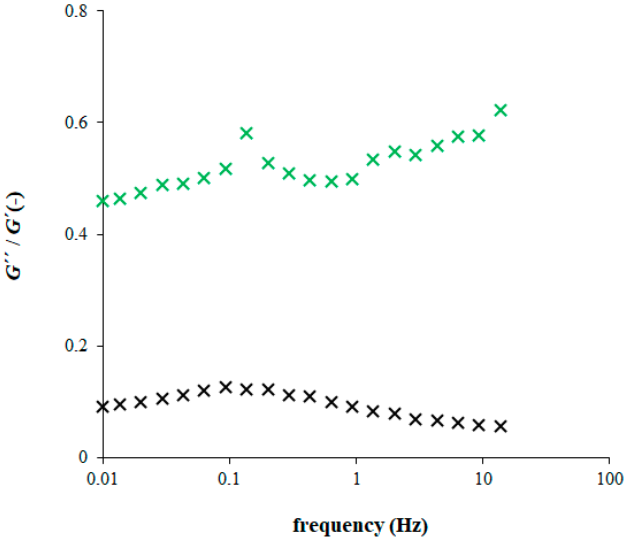
Figure 6. The ratio between loss ( G ´´) and storage ( G ´) moduli (pure agarose hydrogel–black; hydrogel enriched by chitosan (1 mg g − 1 ) ‐ green).